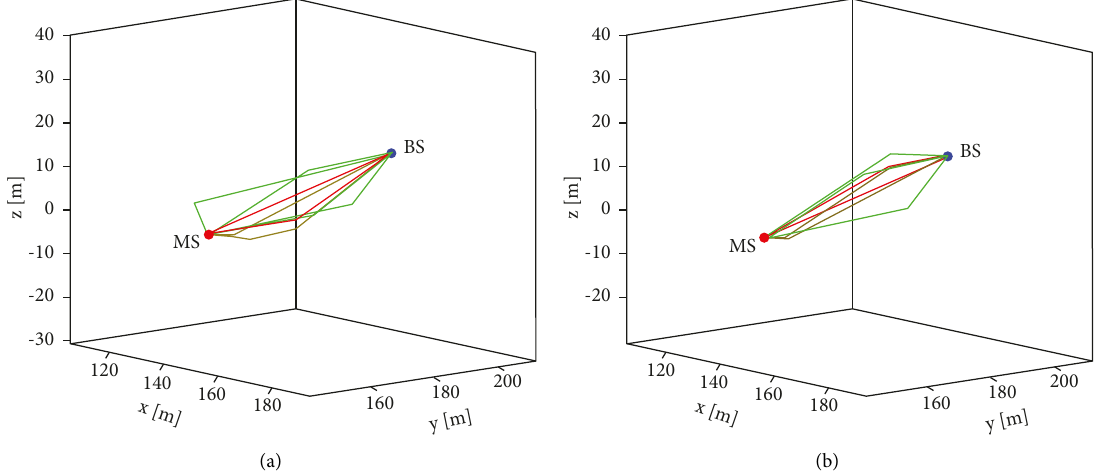
Figure 4: Diagrams of nonreciprocal beam patterns, the T-R separation distance is 72.8m. (a) Downlink: BS beamwidth 30 ° , MS